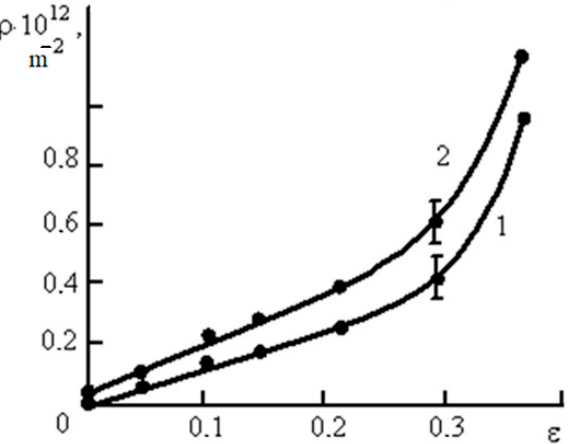
Figure 11. Dependence of the scalar dislocation density on the degree of plastic deformation of Had- field steel for grains containing microtwins (curve 1) and for grains without microtwins (curve 2). When twinning with respect to the pole (111) γ , the indices of the extension axis [ 31(cid:3364)2 ] γ change to [ 1(cid:3364)50 ] tw . The calculated Schmid factors for operating sliding systems in the ma- trix and twin are presented in Table 2. Table 2. Schmid factors for existing sliding systems for the sample area in Figure 10c. Sliding Systems